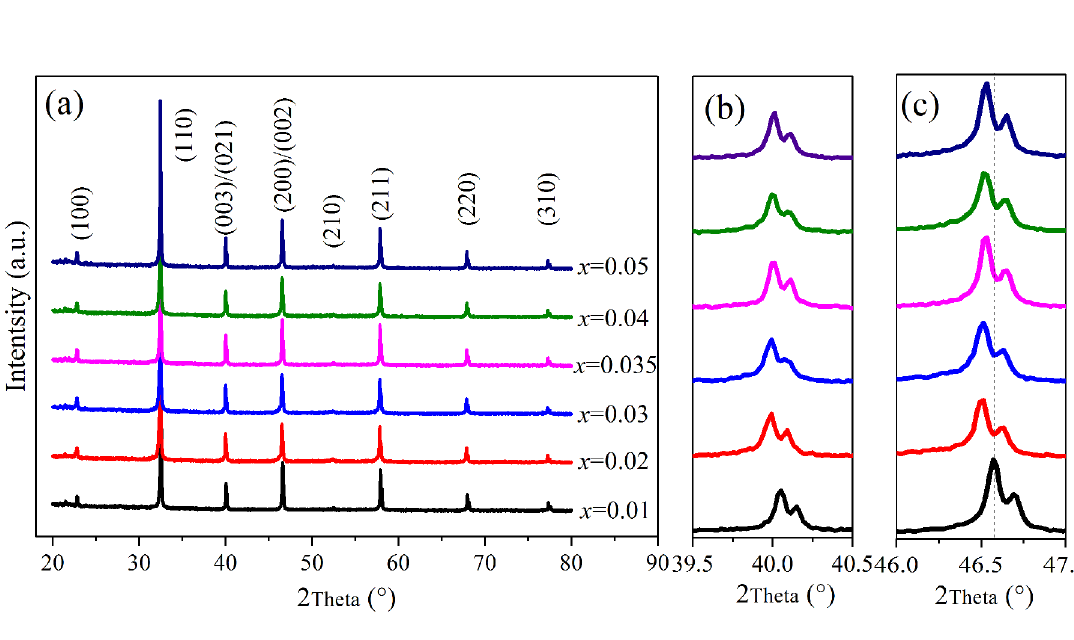
Figure 1. XRD patterns of BNBT- x NT ceramics at (a) 20°-80°, (b) 39.5°-40.5° and (c) 46°- 47°